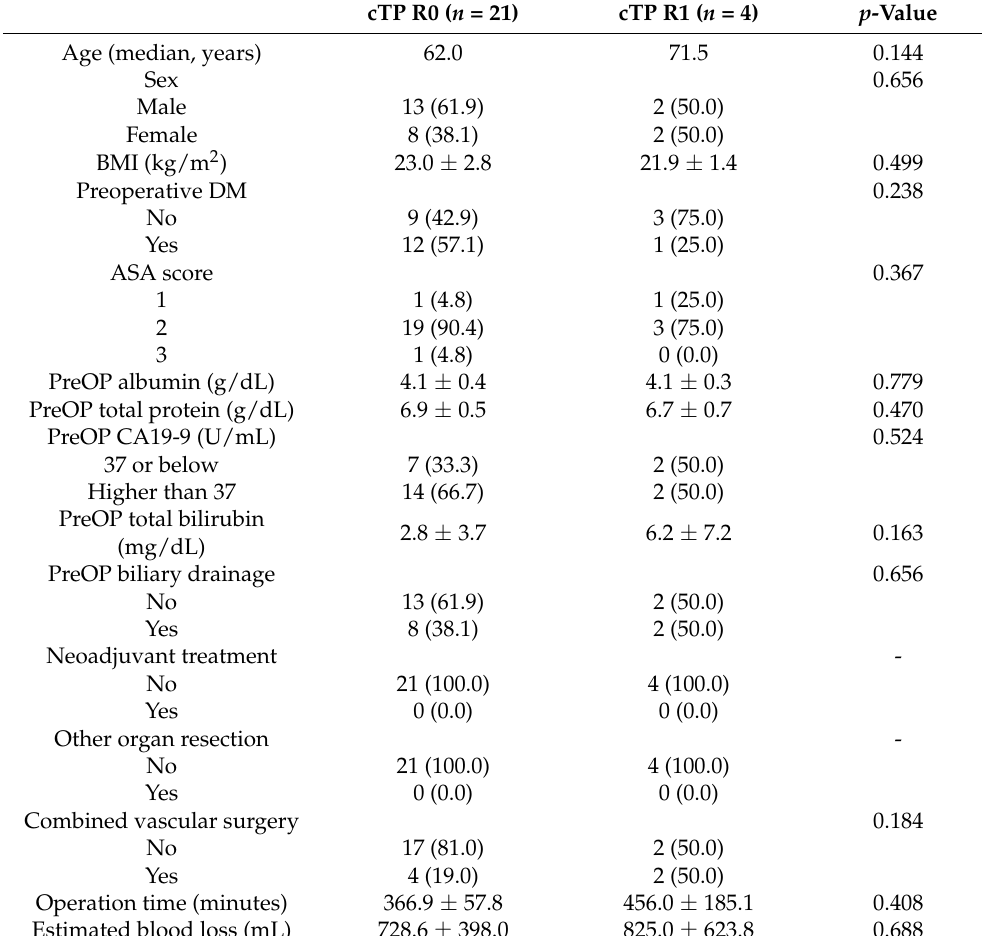
Table 1. Comparison of clinical and operative characteristics between R0 cases and R1 cases after cTP (number (percent) and mean ± standard